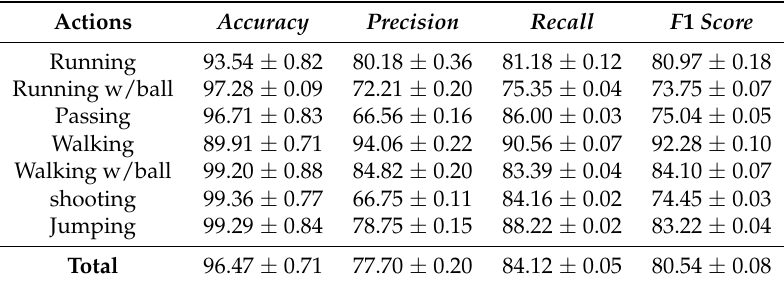
Table 10. DBMM Evaluation